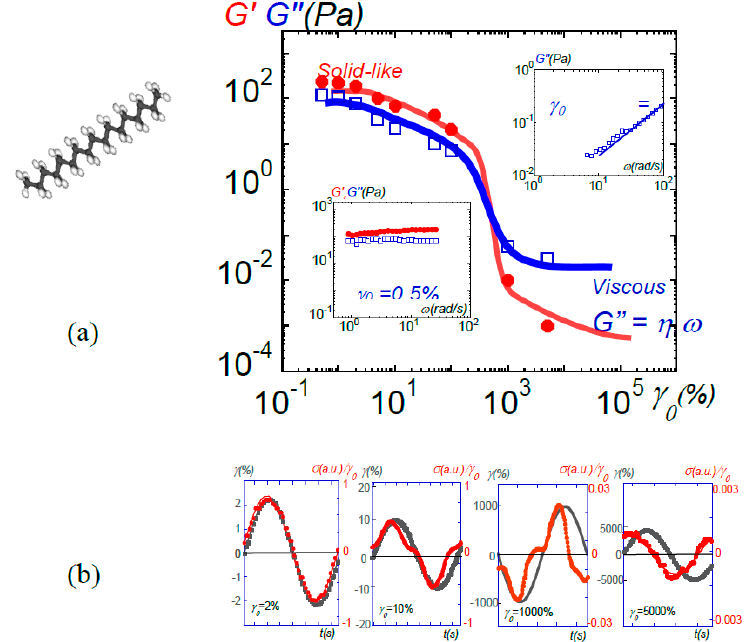
Figure 14. ( a ) Transition from solid-like to viscous behavior-induced response in liquid n-heptadecane at 24 °C by increasing the strain amplitude ( γ 0 ). The data points display the shear (G’(•)) and the viscous (G”( □ )) moduli at ω = 1 rad/s. At low strain amplitude, a solid-like behavior is observed. The moduli in the intermediate non-linear regime are not presented since the signal is not a sinusoidal wave. At very large strain amplitudes, an apparent viscous behavior is displayed. ( b ) From left to right: input sin wave ( ■ : strain amplitude γ (%)) and output shear stress wave (•: shear stress: σ (a.u.)) corresponding to the liquid at different imposed strain amplitudes ( γ 0 = 1, 10, 1000 and 5000%, e = 0.058 mm), reproduced with permission from [47]. Similar behaviors are observed in polypropylenglycol, water, ionic liquids...